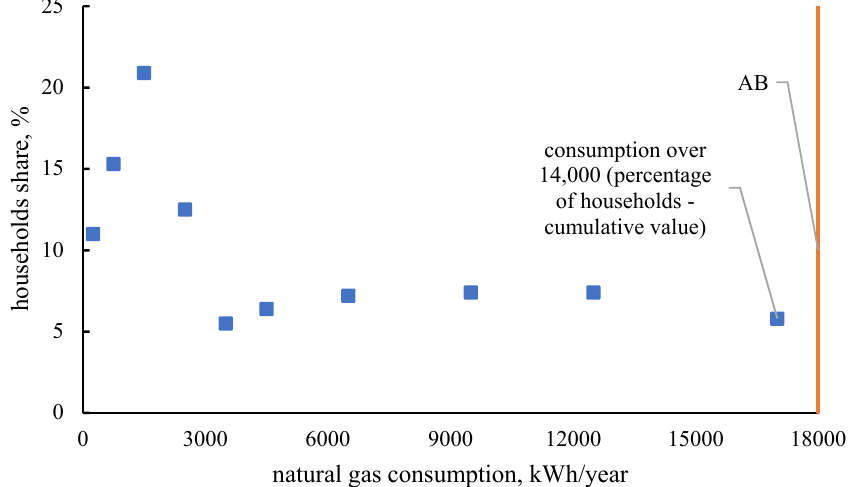
Figure 5. Distribution of electricity consumption of households in Poland together with a comparison for the analyzed building (characteristic p. 2.2) Source: own study based on [1].